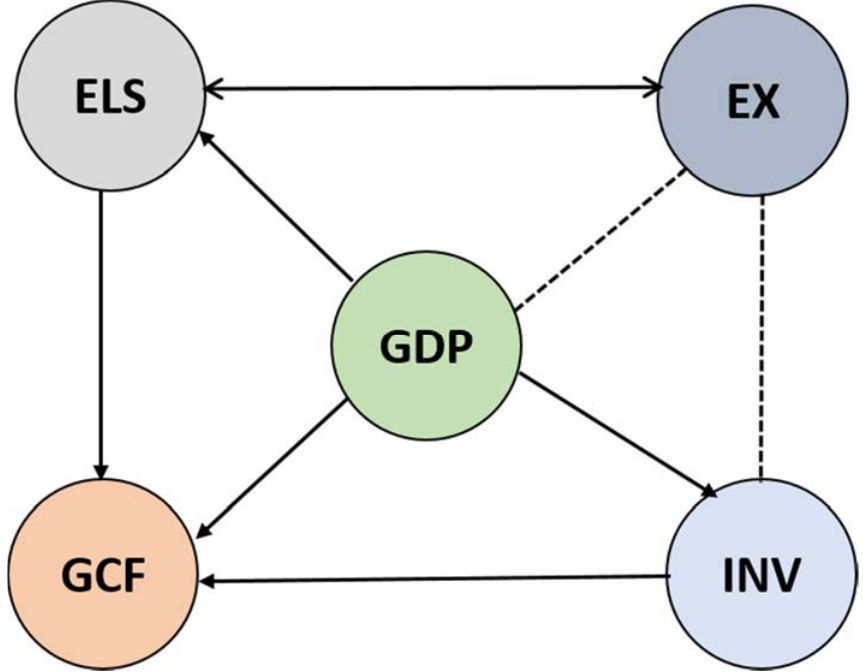
Figure 7. Causality among electricity supply, economic growth (GDP), export, investment and gross capital formation. capital